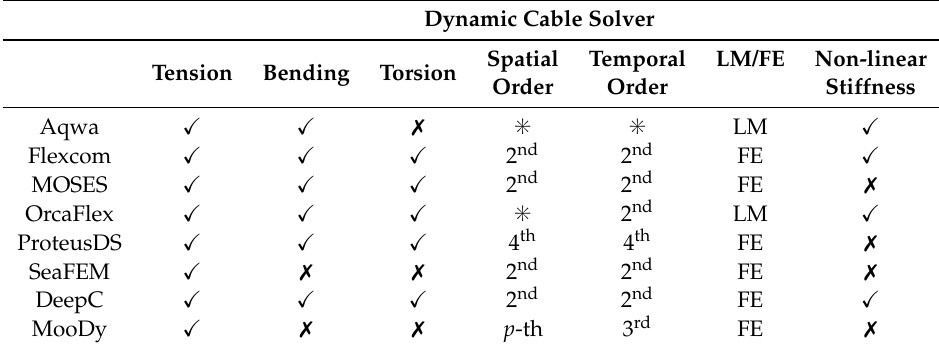
Table 4. Comparison of capabilities of the implemented cable solvers in the investigated software packages. (cid:88) and (cid:55) denote respectively that the capability is available or unavailable. (cid:83) indicates that no information could be found in the public available theory manual. LM and FE denote respectively a discrete lumped mass and finite element approach. p -th indicates that the order is